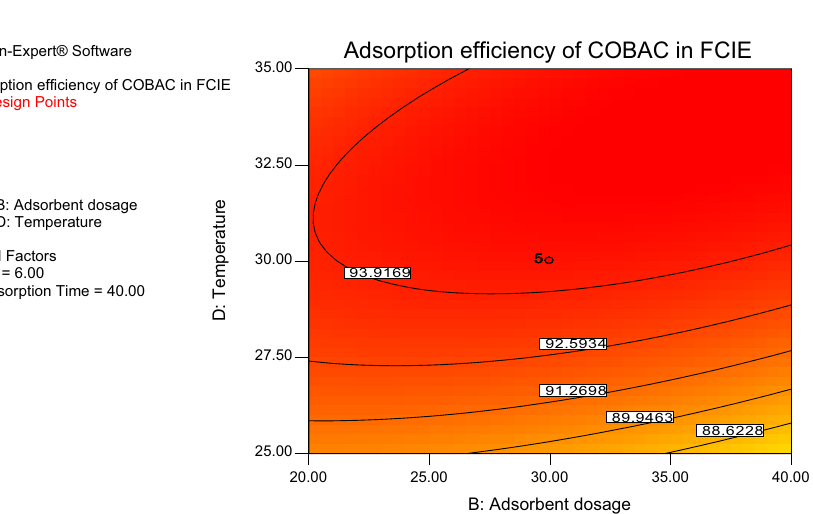
Fig. 10 Contour plot